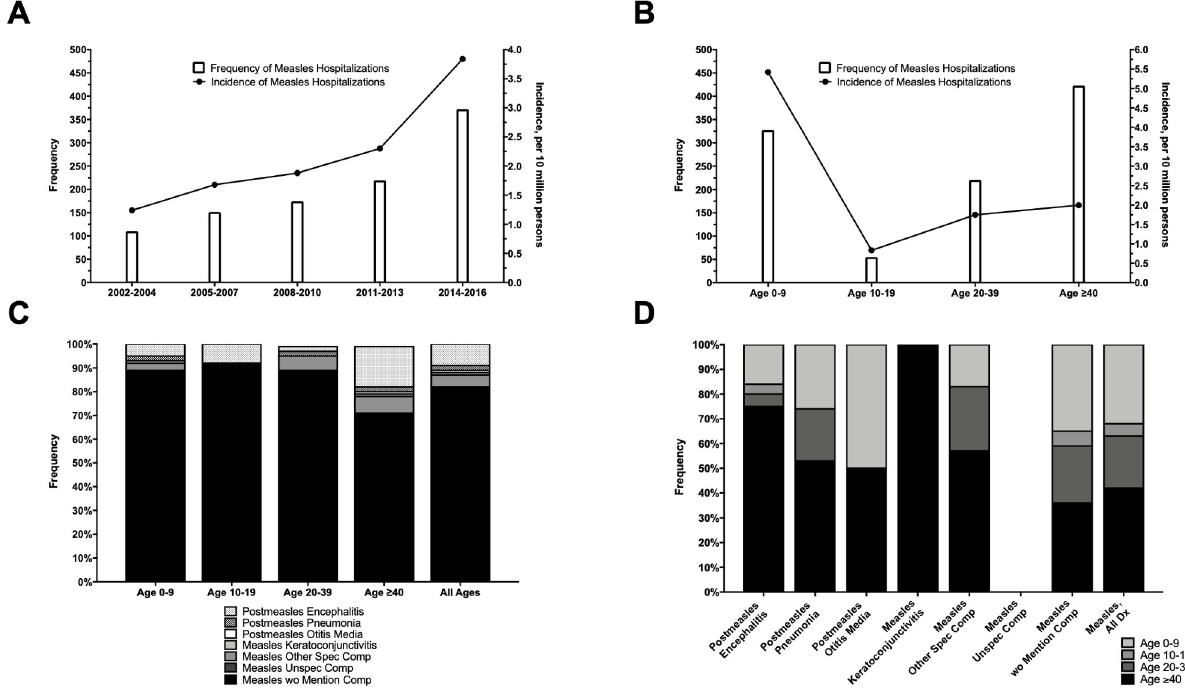
Fig 1. Frequency of measles hospitalizations. Measles hospitalizations by year (A), age (B), age stratified by ICD code (C), and ICD code stratified by age (D).